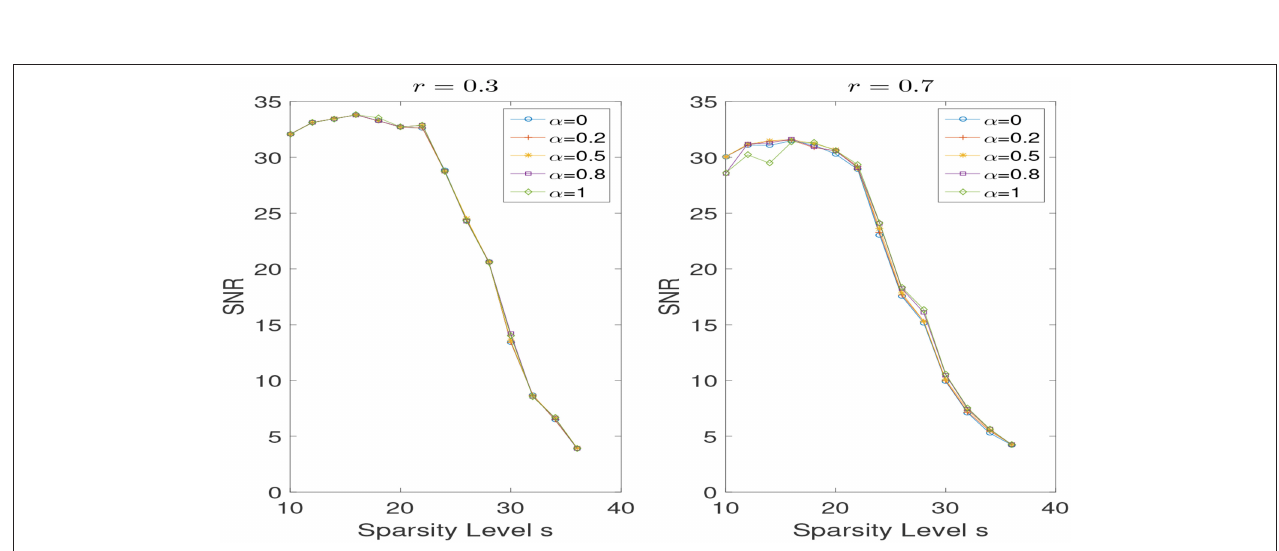
0.3 and r 0.7 in the noisy case, while varying the sparsity level s = =